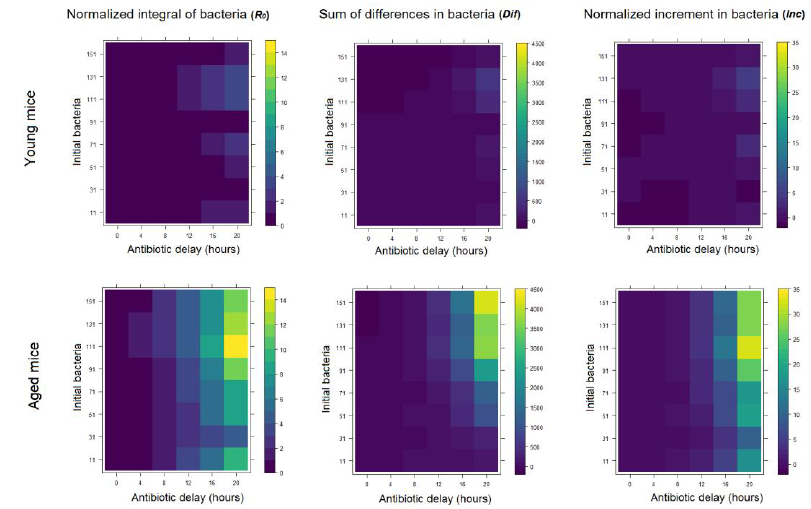
Figure 2. Three different bacterial indicators to compare nominal versus aged conditions in the model for different initial bacteria and antibiotic delay. The first column considers the measurement R 0 (Basic reproduction number: an estimate of the potential dispersion of the infection through the lungs), the second column uses the measurement Dif (diference: average of the increase rate of the bacteremia) and the third one the Inc (increment: bacteremia at the last stage of infection). Figure 3 further elaborates on the effect of τ and age on bacteremia. The figure shows the expected pattern of decrease on the amount of bacteria after antibiotics administration in all the scenarios simulated. However, only in the simulation for young individuals with τ = 12 h (Figure 3A, middle) bacteria levels at the end of the simulation are comparable to the initial state and hence a refle ction of successful depletion of the infection. In contrast, in aged individuals and τ = 12 h the bacteremia is decreasing from its maximum levels at the end of the simulation, but still stays very high (Figure 3B, middle). To control the bacteremia at the end of the simulation in aged individuals, one has to administer the antibiotics at τ = 4 h (Figure 3 panel B, left).